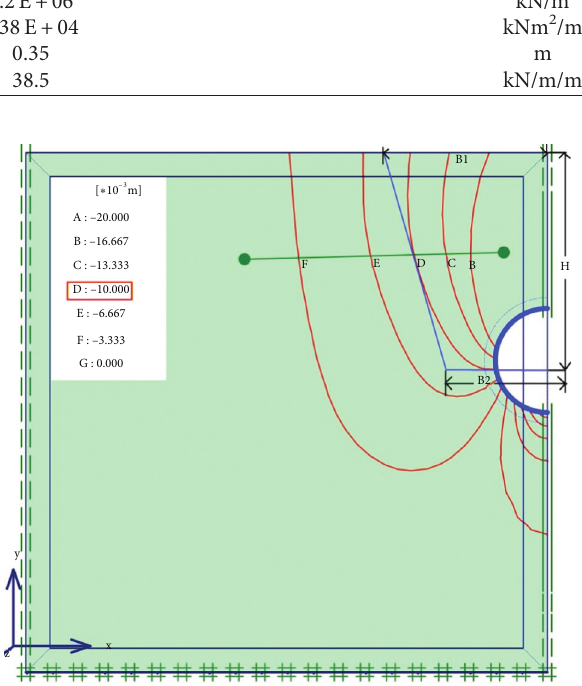
Figure 4: Settlement contour. From different contours 10mm settlement contour “ D ” is